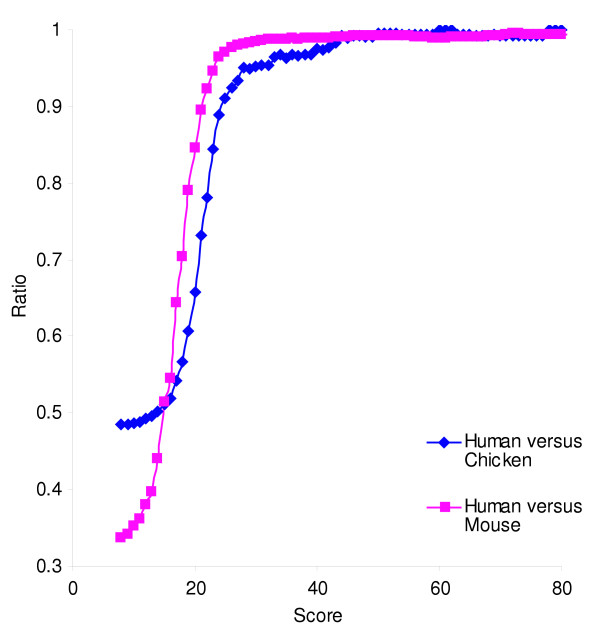
A plot showing the ratio of +/+ orientation promoterwise alignments (being collinear with the direction of transcription) versus all alignments for human/mouse (blue lines) and human/chicken (magenta) promoters. The x-axis is the bit score range, binned in 1 bit intervals. The y-axis is the ratio of +/+ alignments to the total number in this range. All species except mouse/rat show similar 'step' behavior between 20 and 25 bits. The depression below 0.5 of mouse/human alignments at low bit scores at first seems surprising, as one expects random data to show a 0.5 ratio. This depression is because there is a significant amount of +/+ alignments which, when close to random alignments, will often capture low scoring alignments, especially if it is straddled by two high scoring alignments, and merge into one high scoring alignment. As this predominantly occurs in forward/forward alignments, this means that there is a depression of low scoring forward/forward alignments.